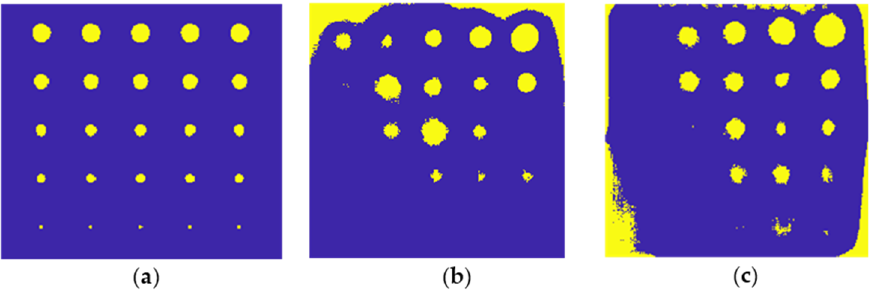
Figure 18. The results of the neural network classification executed on the experimental data. ( a ) The reference image with the defect and non−defect pixels labeled manually, ( b ) the result of classification for sample S1 and ( c ) S2.